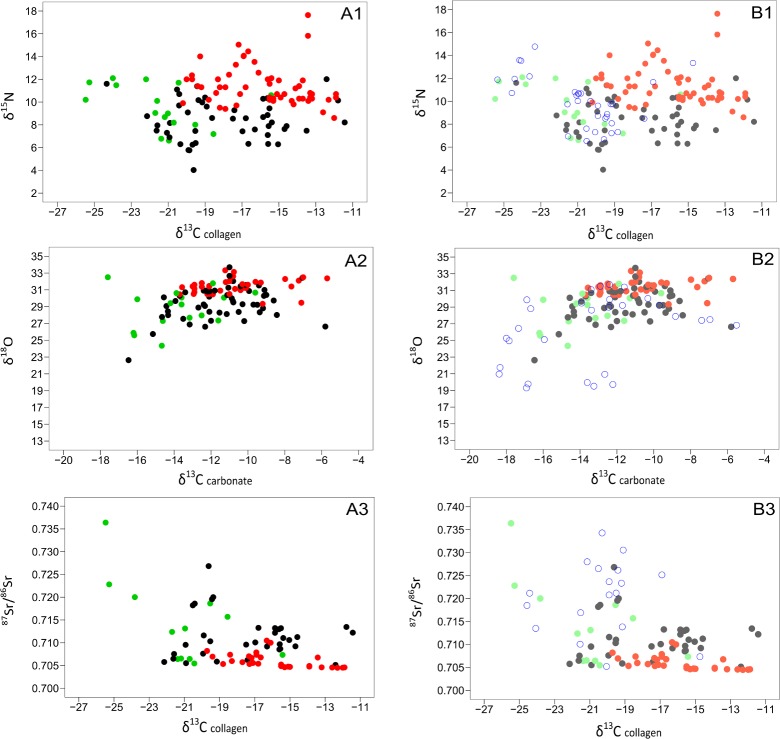
δ13C, δ15N, δ18O and 87Sr/86Sr values for modern, historic, and unprovenanced elephant samples from East Africa.(A1-3) Three plots of modern (post-1950) and historic elephant tissue samples collected from museum specimens, national parks in Tanzania (see S1 Table), and including modern published data from [39,41,42]. Colours of all samples correspond to habitat following [41] for East African elephant habitats: green is forest/mountain, black is savanna mosaic (incorporates woodland/bushland/grassland habitats) and red is arid (incorporates arid bushland and grassland habitats), with habitat descriptions following [97]. (A1) δ13C and δ15N values of collagen, (A2) δ13C and δ18O values of carbonate, and (A3) δ13C and 87Sr/86Sr values, from collagen and carbonate respectively. (B1-3) Three plots of all samples included in (A1-3) are lightly shaded and in blue open circles, the unprovenanced ivory samples from museum collections (see S1 Table). (B1) δ13C and δ15N values of collagen, (B2) δ13C and δ18O values of carbonate, and (B3) δ13C and 87Sr/86Sr values, from collagen and carbonate respectively.